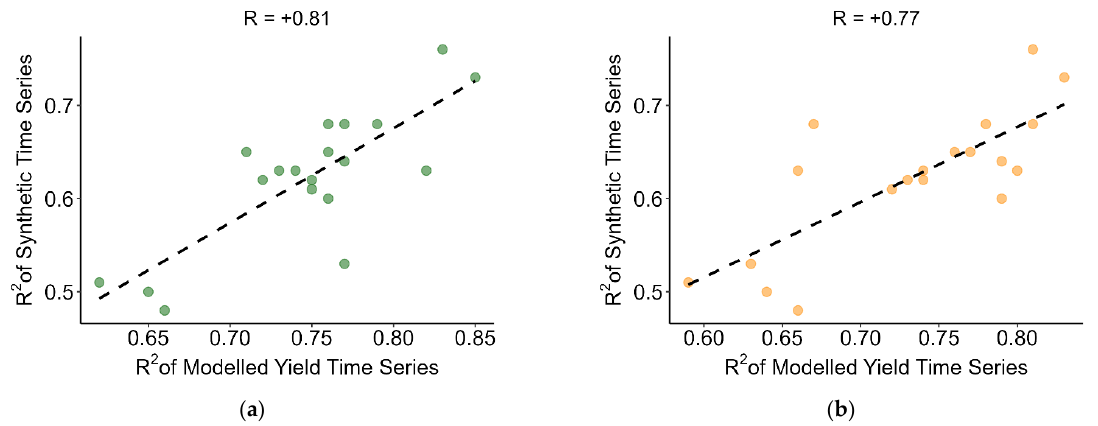
Figure 14. The bar plots compare the yearly ( a ) R 2 and ( b ) RMSE values of estimated OSR yield (orange), WW yield (green), and synthetic NDVI (purple) from 2001 to 2019. The units of the RMSE values of both WW and OSR yields are dt/ha.